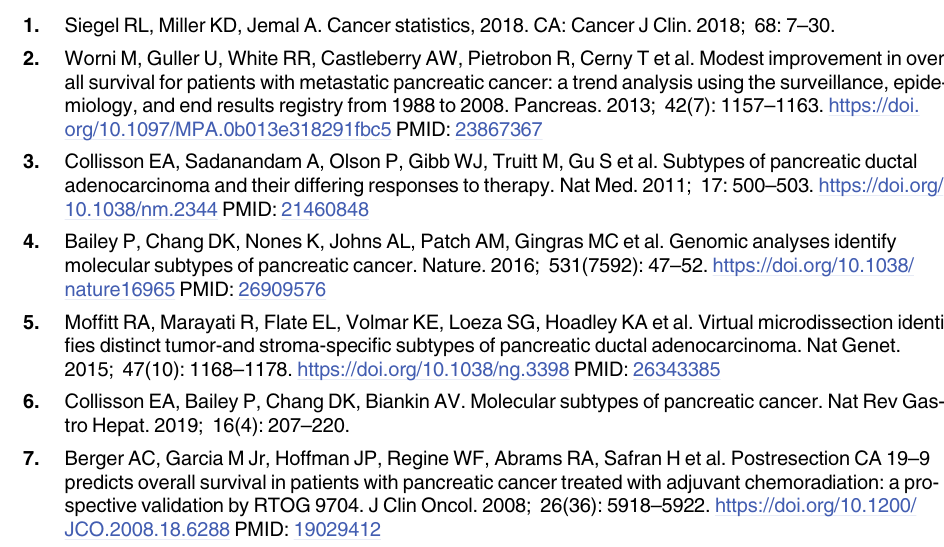
S2 Table. Summary of quality assessment. S3 Table. PRISMA